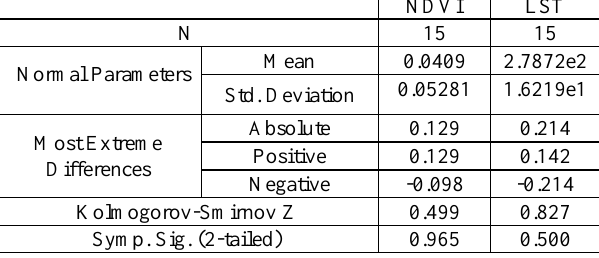
Table 2. Test distribution is normal and results of